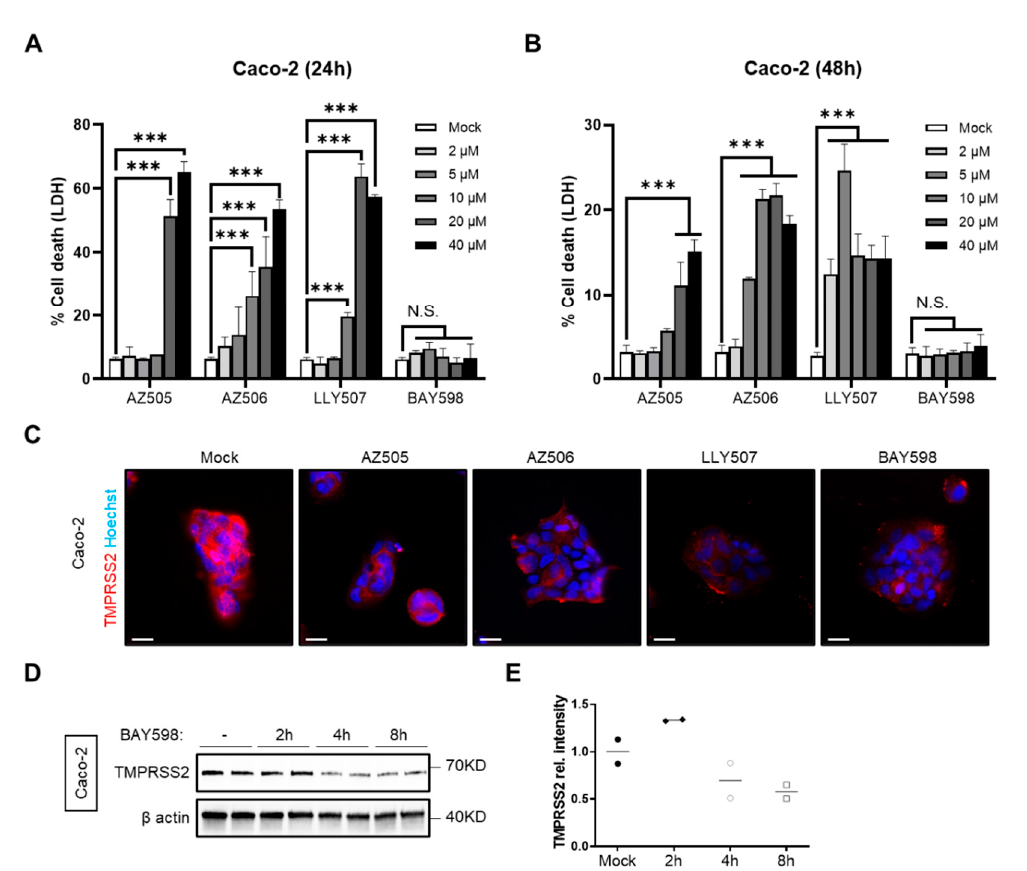
Figure 3. SMYD2 inhibition decreases TMPRSS2 expression in Caco-2 cells. ( A , B ) LDH release assay from Caco-2 cells treated with increasing concentrations of AZ505, AZ506, LLY507, or BAY598 for 24 h ( A ) and 48 h ( B ). Experiments were performed two times and representative data are shown. *** p < 0.001. N.S., not significant. ( C ) Immunofluorescence staining of TMPRSS2 in Caco-2 cells stimulated with vehicle (mock), 10 µM AZ505, 10 µM AZ506, 10 µM LLY507, or 20 µM BAY598 for 8 h. Scale bar, 10 µm. ( D ) Immunoblot analysis of TMPRSS2 in lysates of Caco-2 cells stimulated with 20 µM BAY598 at different time points. β -actin served as a loading control. ( E ) Densitometric analysis of TMPRSS2 expression.